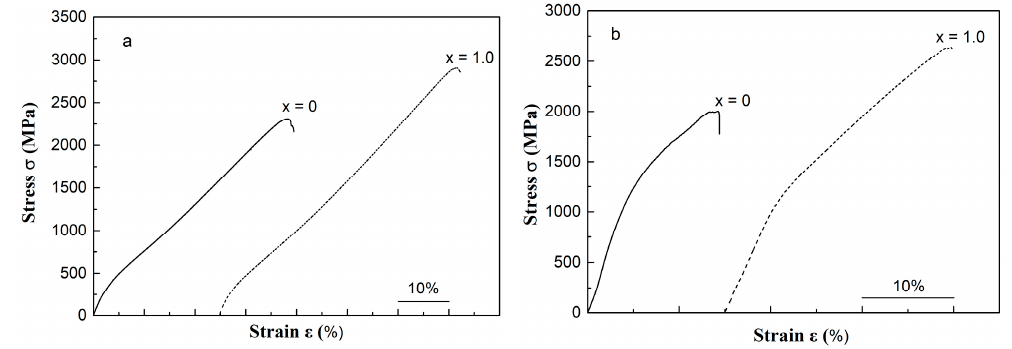
Figure 4. Compressive engineering stress–strain curves of: ( a ) Fe 65.4 − x Ce x Mn 14.3 Si 9.4 Cr 10 C 0.9 and ( b ) Ti 40 − x Ce x Ni 40 Cu 20 (x = 0, 1.0) alloys.